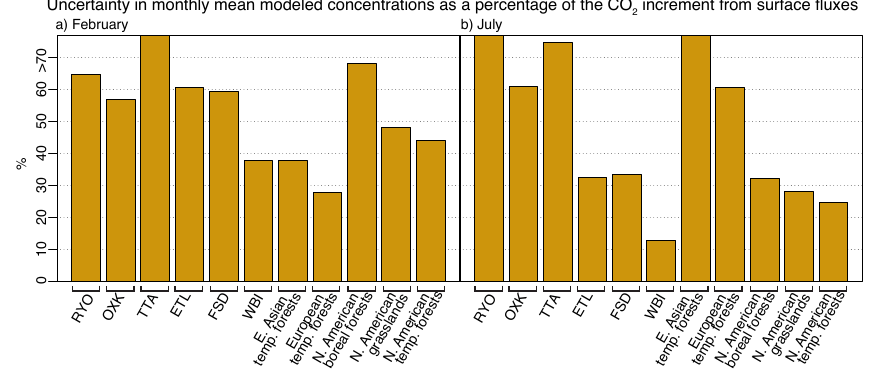
Figure 5. Uncertainty in monthly-averaged afternoon CO 2 concentrations as a percentage of the average afternoon CO 2 boundary layer enhancement. This figure places the uncertainties from Fig. 4 (dark blue bars) in context of the afternoon CO 2 increment from surface fluxes. Larger percentages indicate greater potential for bias in monthly CO 2 budgets estimated from atmospheric